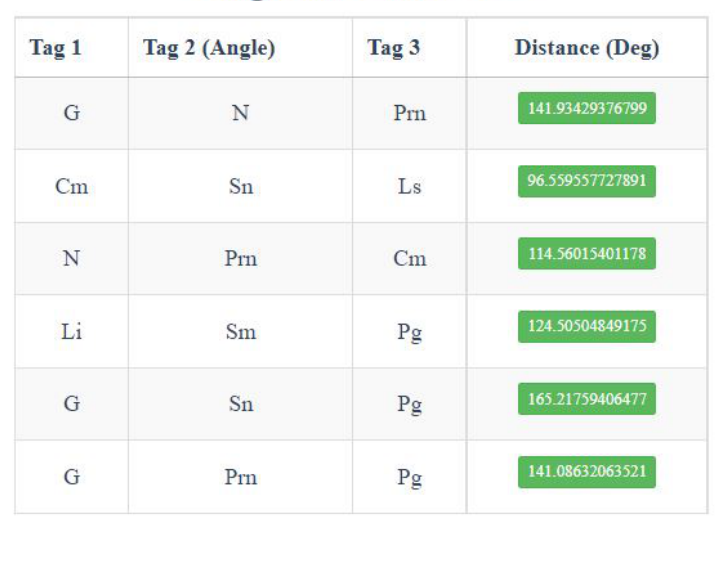
Figure 5. A sample window of linear and angular